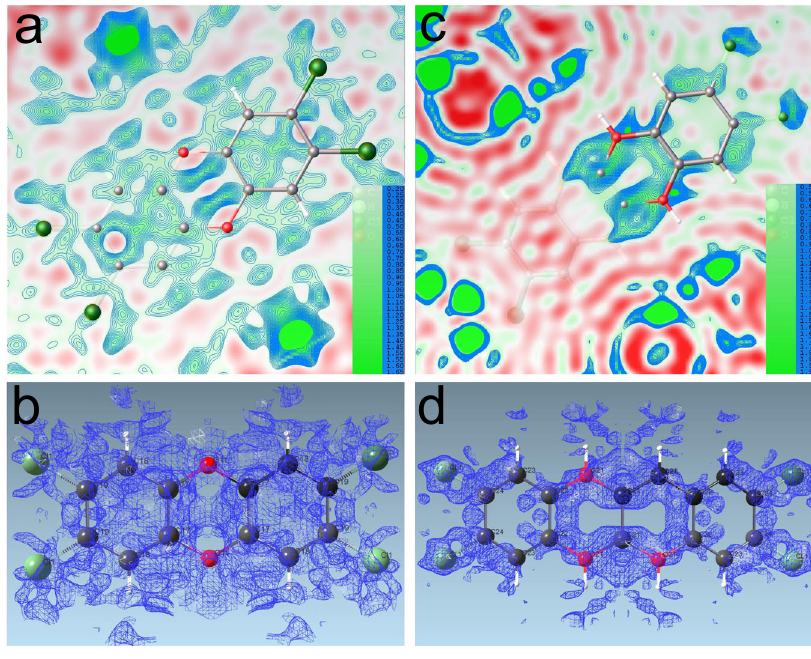
Fig. 1 | F obs electrondensitymaps ofBCDDmolecules in BUT-17. The 2D and 3D F obs electron density maps for the BCDD molecules observed by the previously